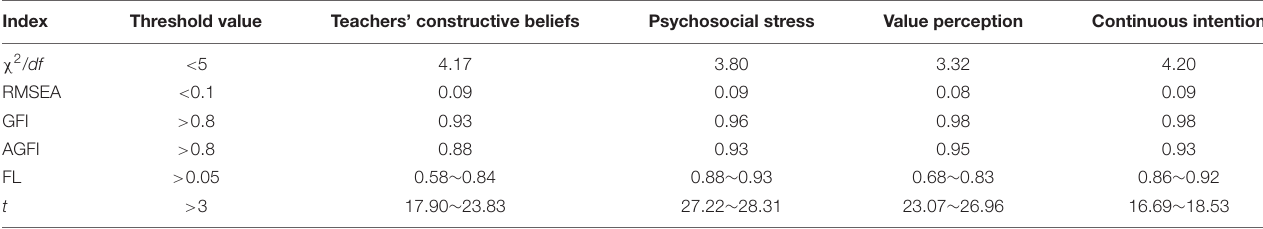
TABLE 1 | First-order CFA for item analysis.